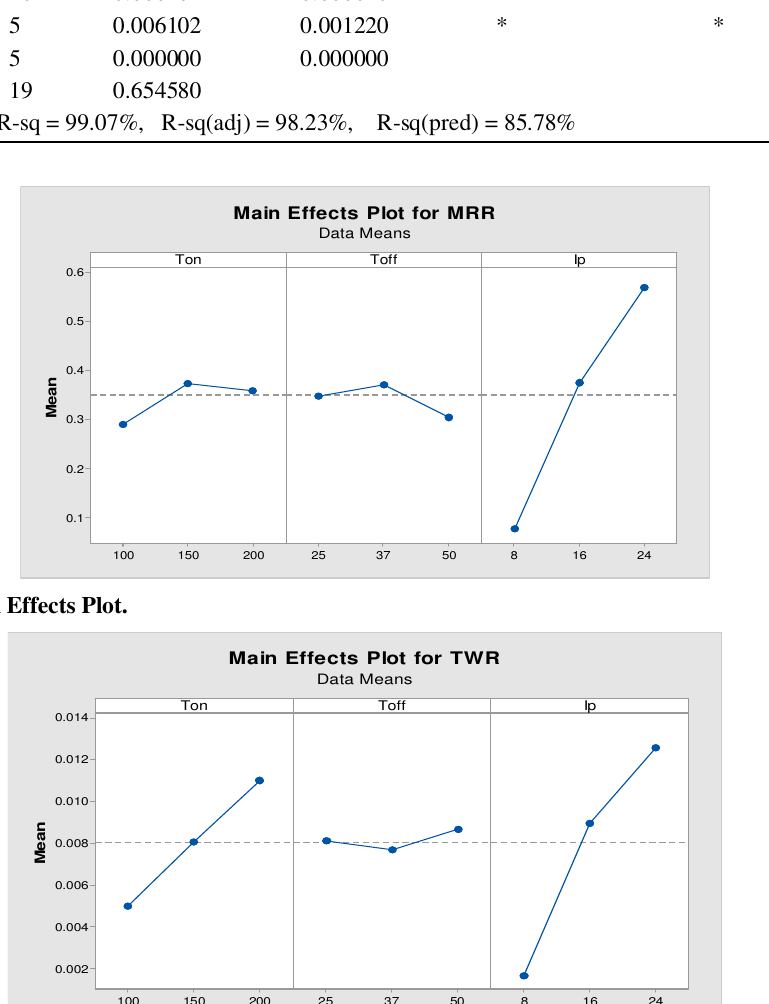
Fig. 4. Tw Main Effects